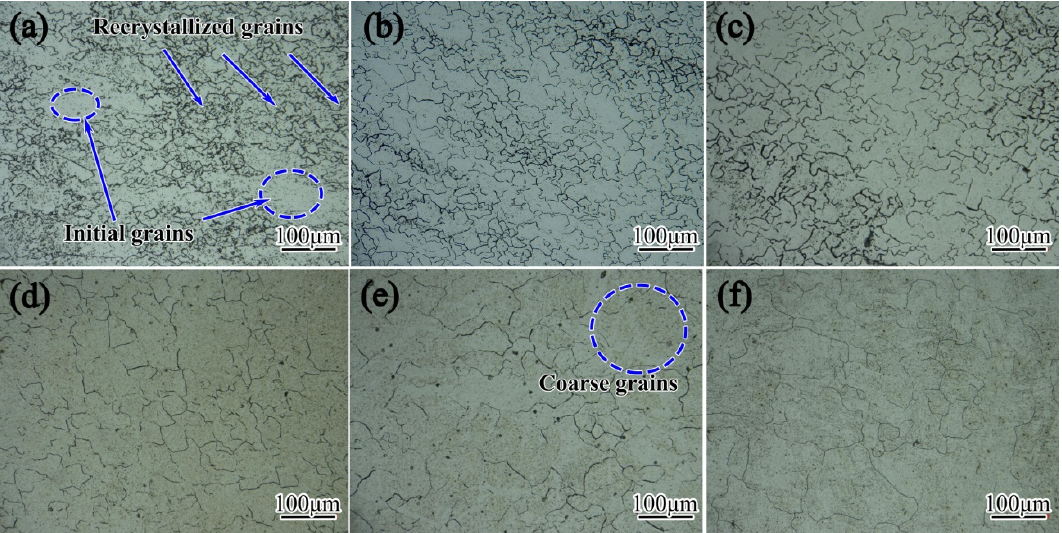
Figure 3. Microstructures of 300M steel compressed at 0.01 s − 1 and at ( a ) 900 °C, ( b ) 950 °C, ( c ) 1000 °C, ( d ) 1050 °C, ( e ) 1100 °C, and ( f ) 1150 °C.